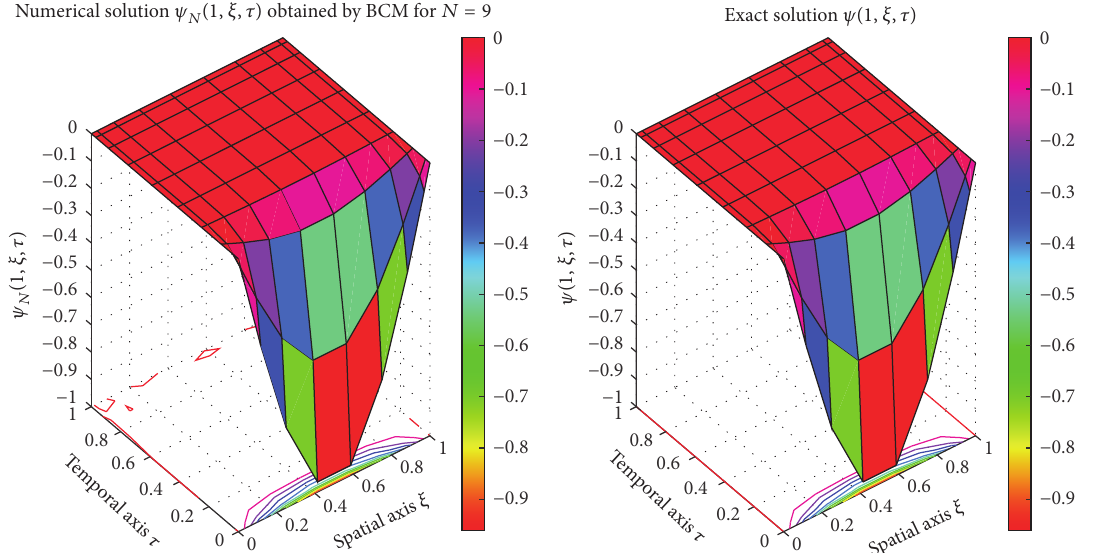
Figure 10: Numerical solution 𝜓 9 (1, 𝜉, 𝜏) and exact solution 𝜓(1,𝜉, 𝜏) of the fourth